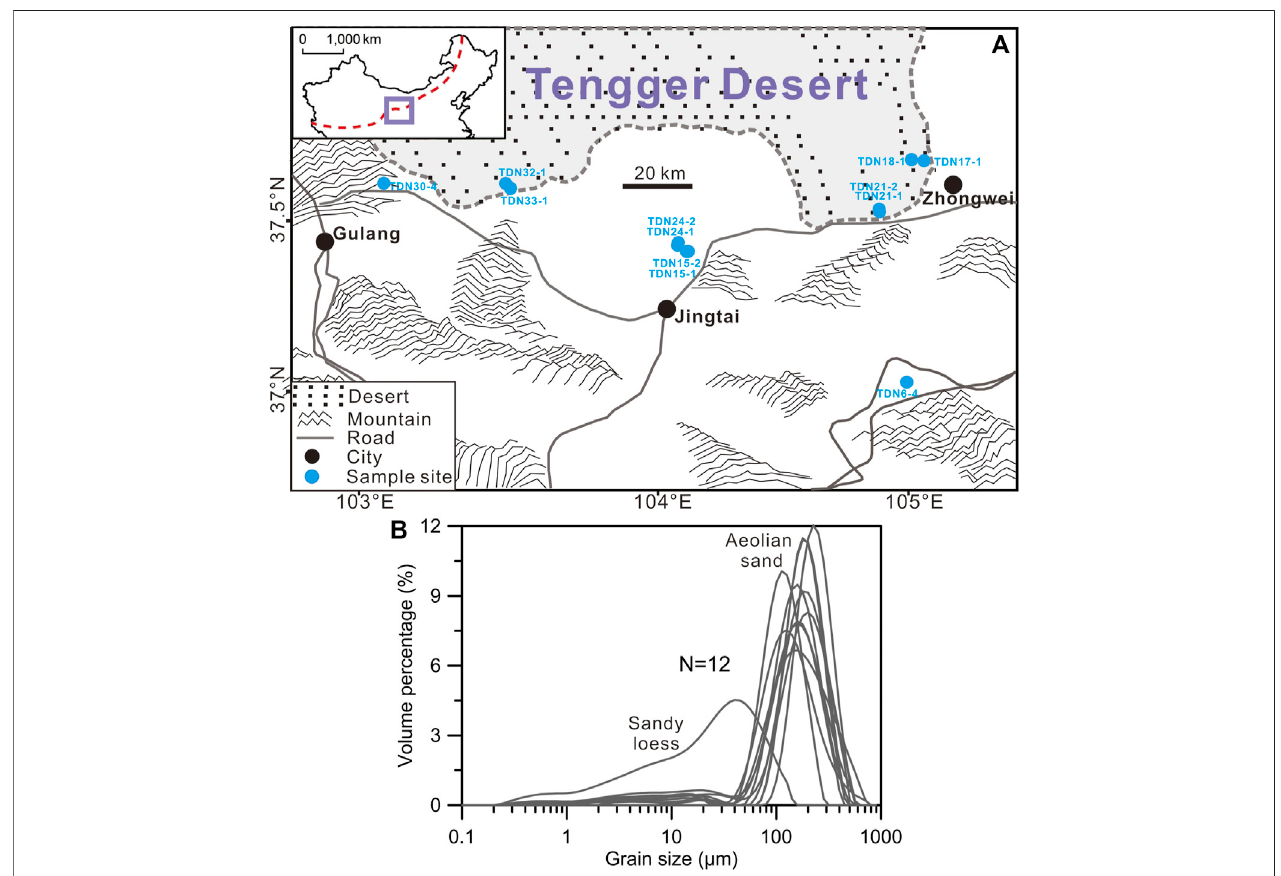
FIGURE1|(A) Sitelocationsoftheinvestigatedsamples.Theboldrectangleintheinsetindicatesthestudiedregionandthedashedredlineindicatestheborderof the East Asia summer Monsoon. (B) Grain-size distributions of the investigated samples.